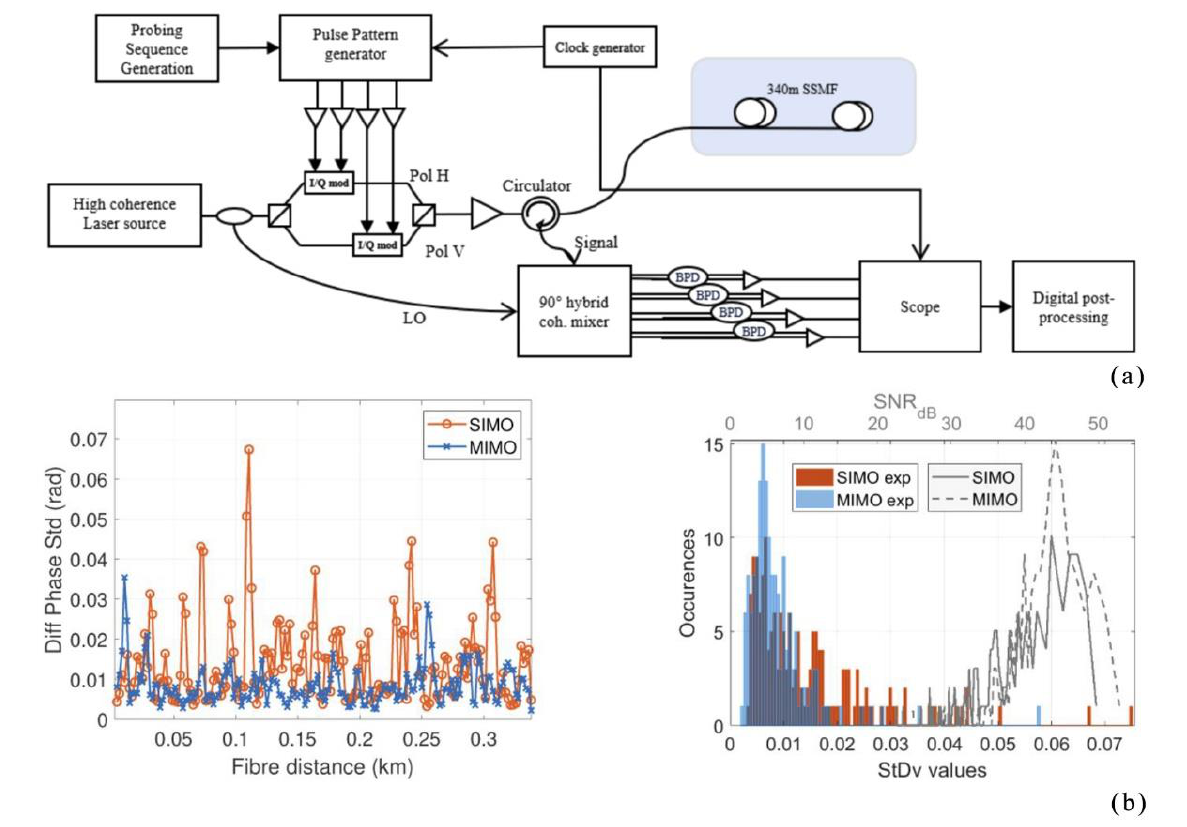
Figure 6. ( a ) Experimental setup. ( b ) SIMO and MIMO measurements on 340 m SSMF, no perturbation applied [35].